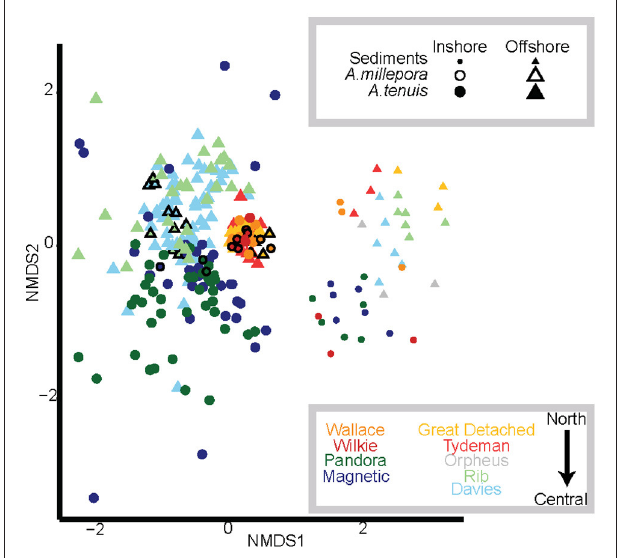
FIGURE 1 | Nonmetric multidimensional scaling (NMDS) of variance-normalized abundances of Symbiodinium OTU’s using Bray-Curtis distances. Symbols and their sizes represent: sediment samples (small circles and triangles), A. millepora juveniles (black outlined symbols) and A. tenuis juveniles (no outlines). Colors denote sector and cross shelf origin of sediment samples, where yellow and red denote northern sediments and juveniles exposed to them; blue, green, and gray colors denote central sediments and juveniles exposed to them. Darker shades represent inshore reef sediments and treatments (Wallace, Wilkie, Pandora, Magnetic); lighter shades represent offshore reef sediments and treatments (Great Detached, Tydeman, Orpheus, Rib,